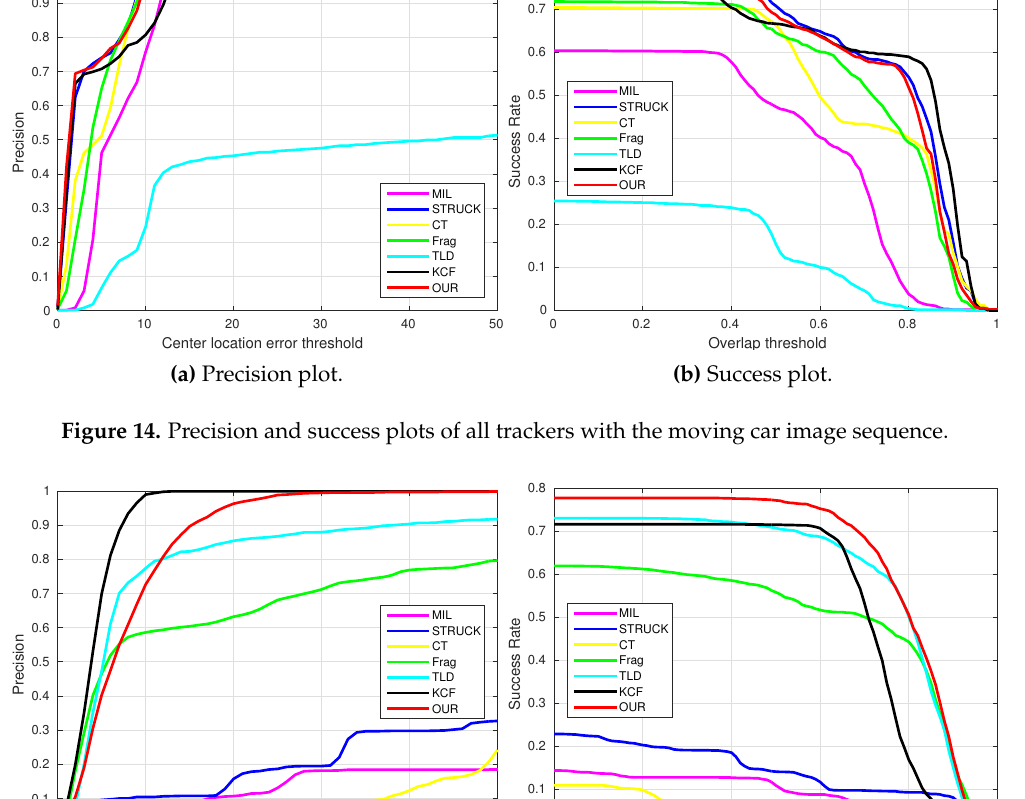
Figure 13. Precision and success plots of all visual trackers with the gas tank image sequence.